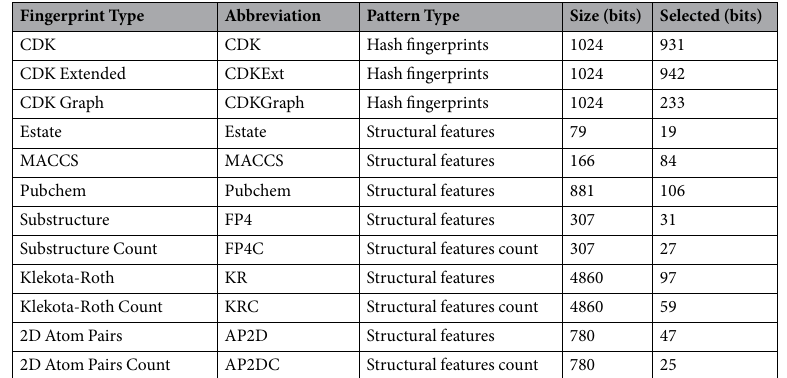
Table 7. Summary of the 12 types of molecular